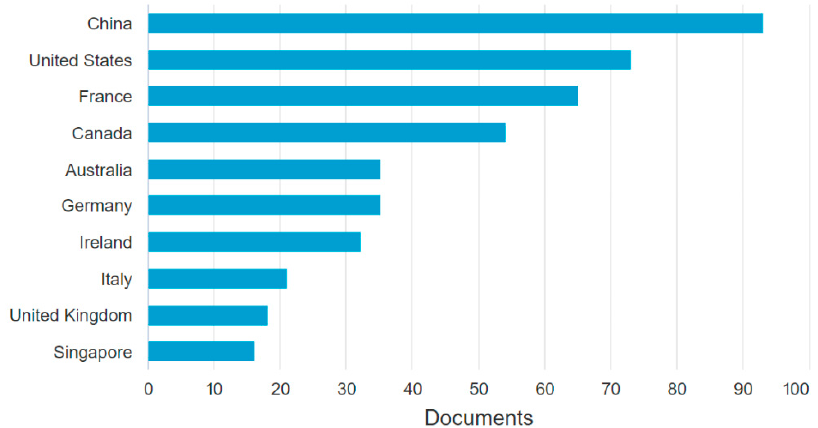
Table 4. The articles most cited in CSAM theme.